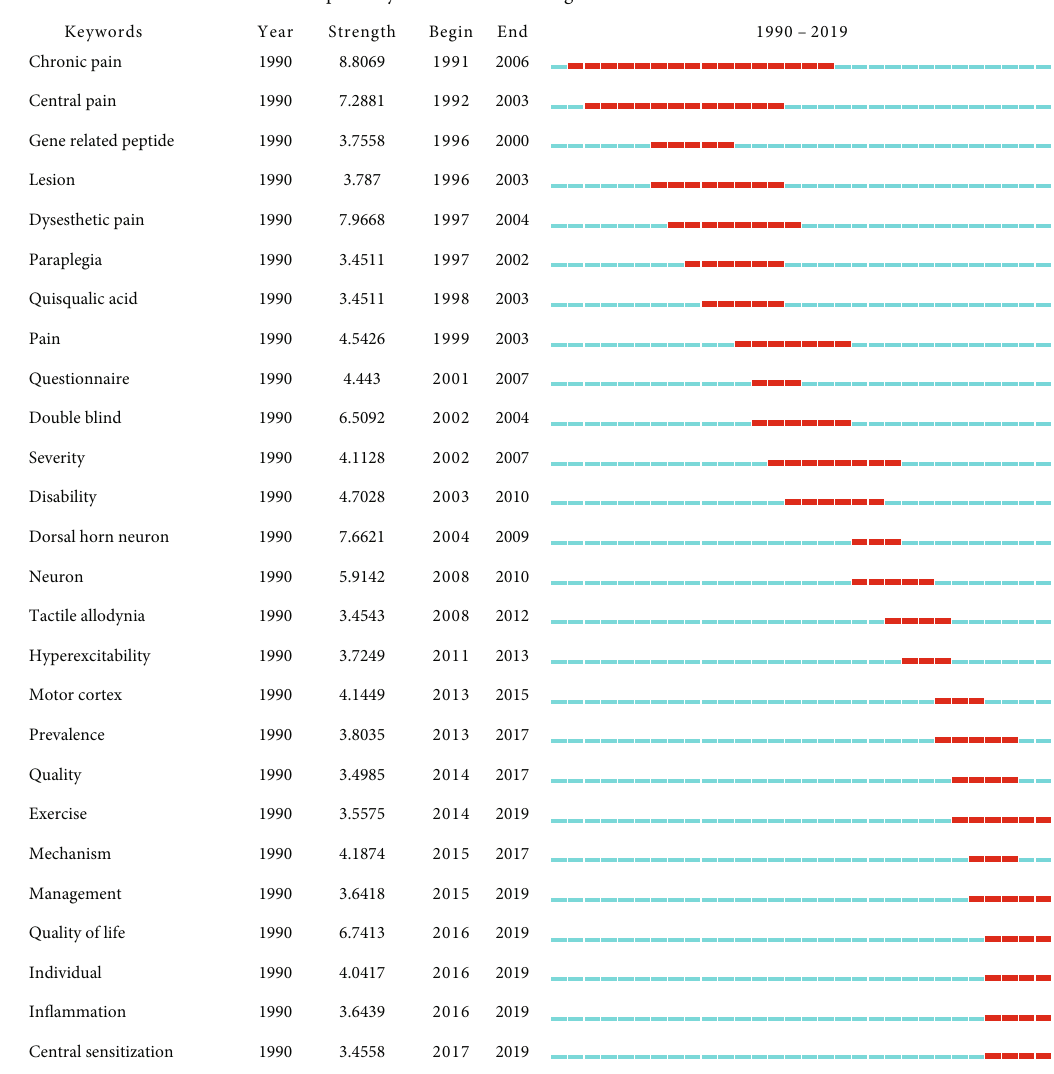
Figure 12: The keywords with the strongest citation bursts of publications on pain after spinal cord